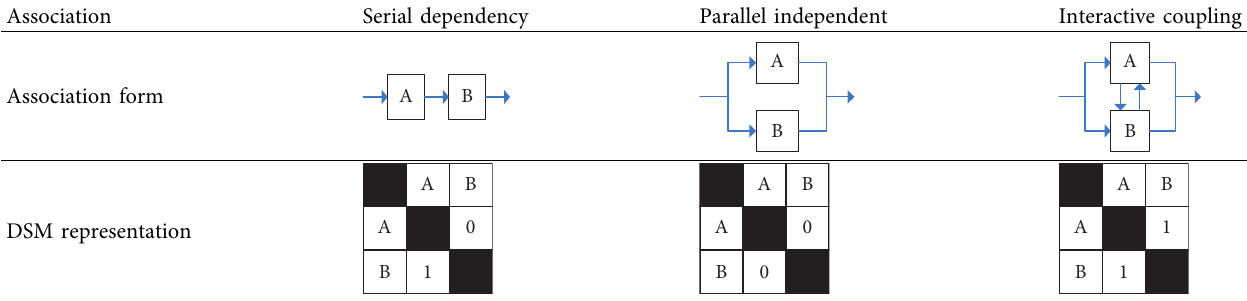
Table 1: DSM and directed graphs describing the system characteristics. Associated description of three activities in the system. Association Serial dependency Parallel independent Interactive